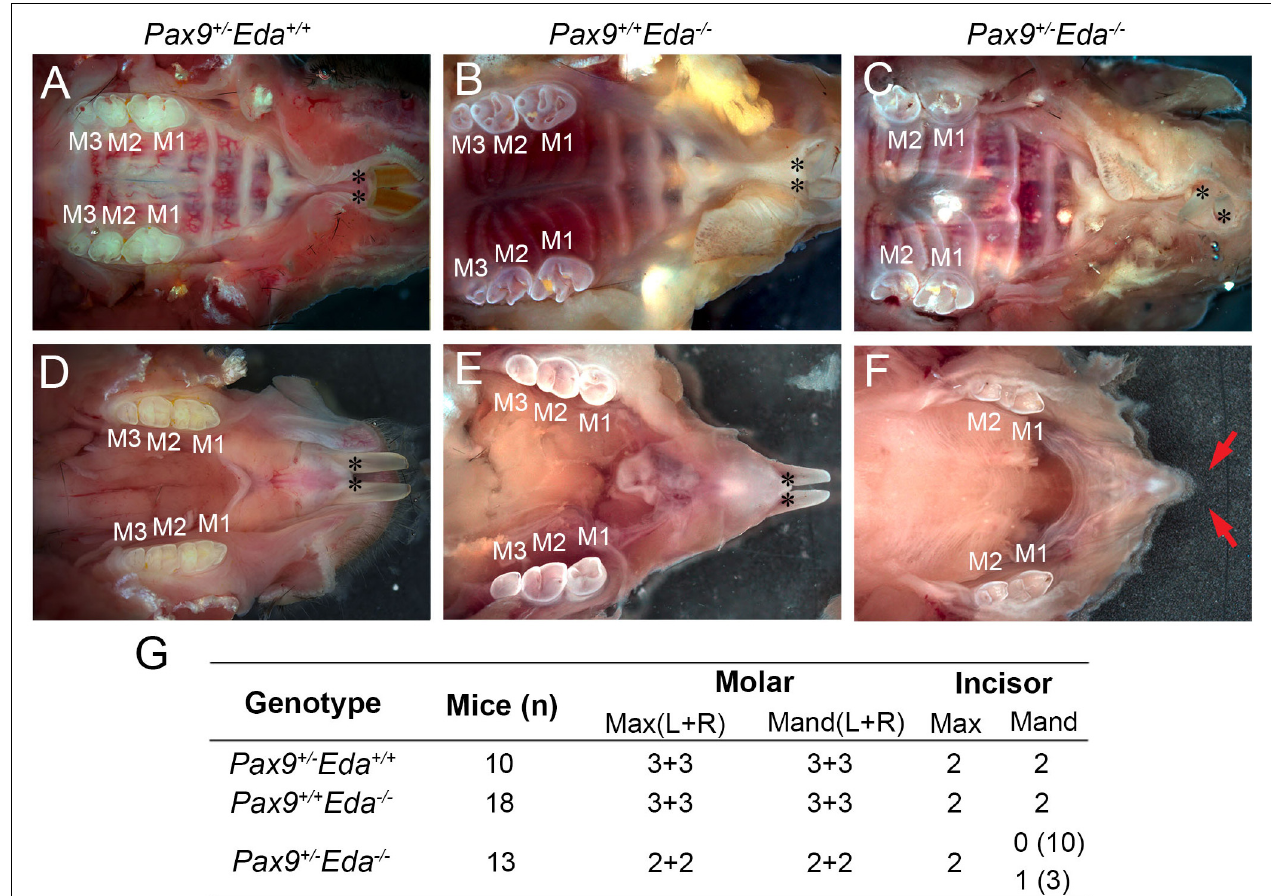
FIGURE 1 | Missing teeth in Pax9 + / − Eda − / − compound mutant mice. (A–C) Whole-mount view of maxillary teeth in 2-month-old mice. (A) Pax9 + / − Eda + / +